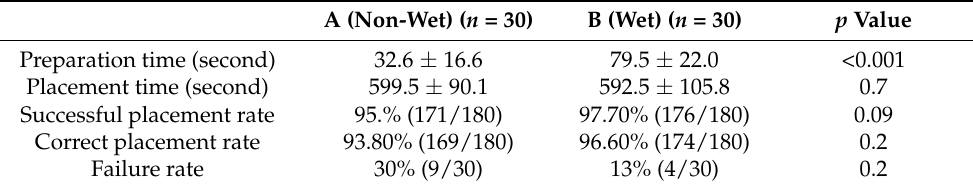
Table 2. Seprafilm placement characteristics.